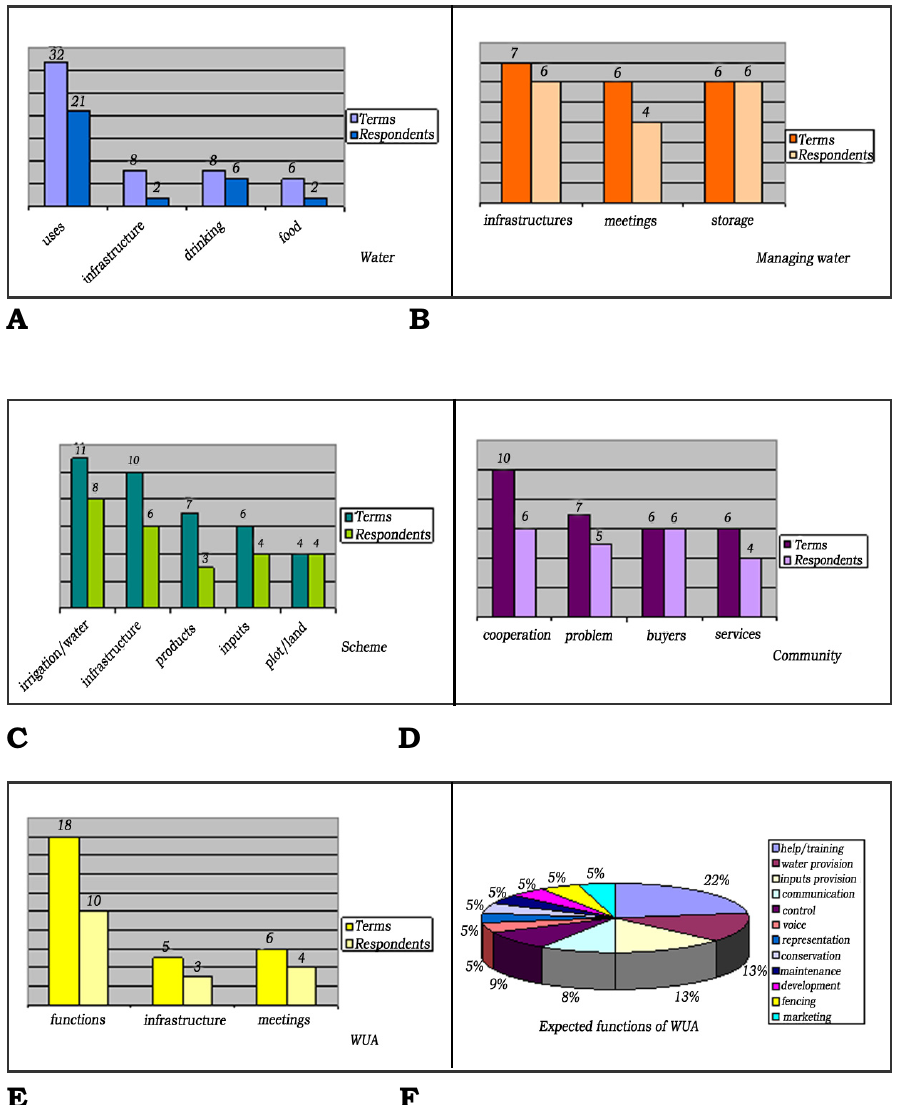
Figure 5 Verbal associations – groups of terms mentioned for each theme1 Source: Thabina Irrigation Scheme – Author’s own data,